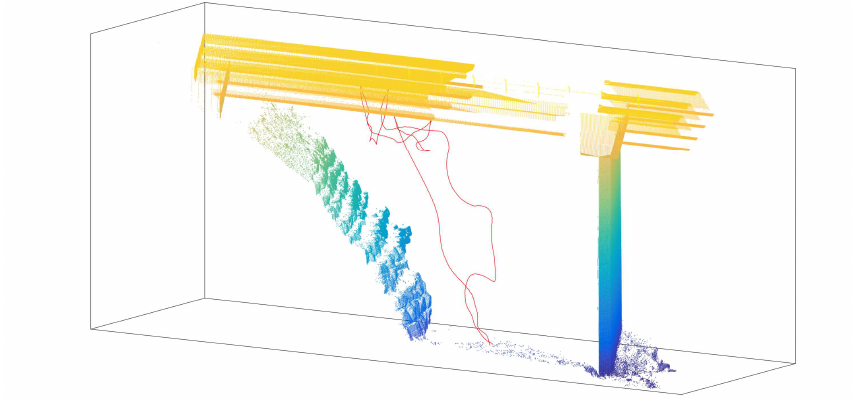
Figure 22. Prism trajectory measured with the laser tracker—Grazalema bridge